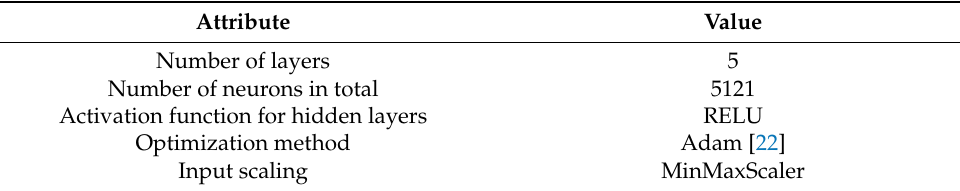
Table 1. Key attributes of the